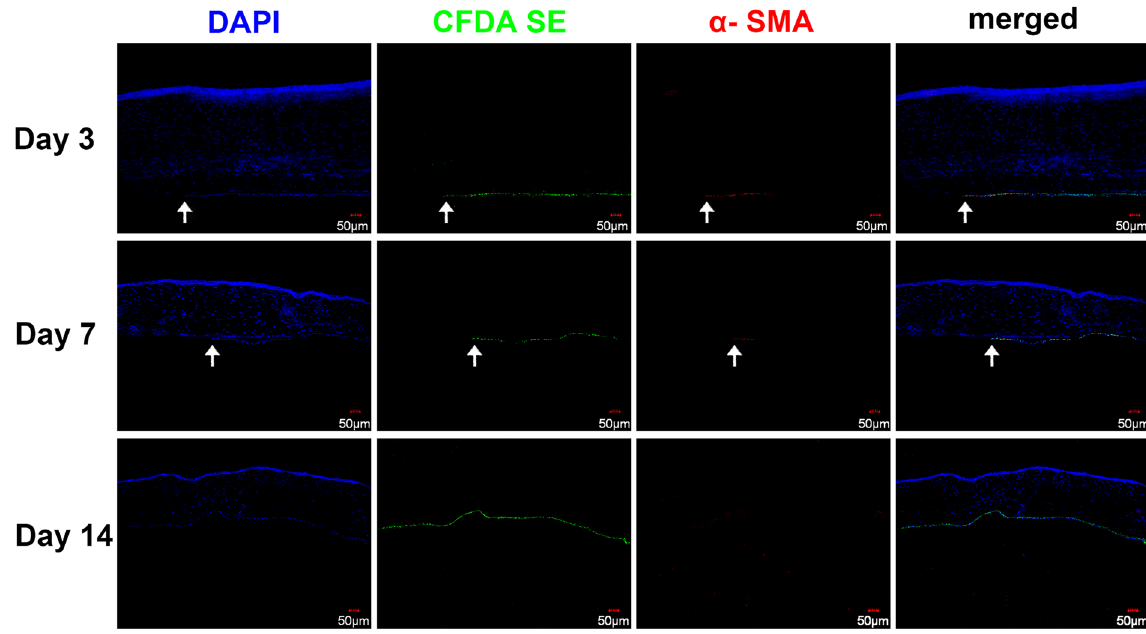
Figure 5. Endothelial cell tracing and α -SMA staining of cornea after CEC scraping. CFDA SE-labeled cells shows the leading edge of CEC injury (arrow) on day 3 and day 7, and complete CEC healing on day 14. Immunostaining showed that CFDA SE-labeled cells close to the leading edge were strongly expressed with α -SMA on day 3 (arrow), decreased on day 7 (arrow), and became negative on day 14. Bars represent 50 μ m.